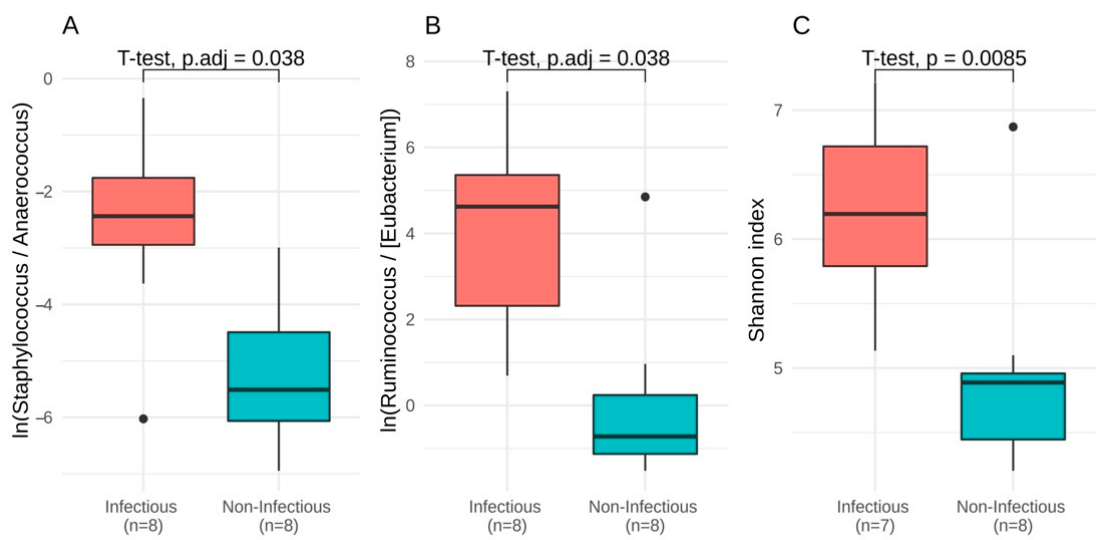
Figure 3. Difference between groups at the baseline. ( A , B ) Balances between taxa obtained by discriminative balance analysis and significantly different between groups. ( C ) Shannon index (only samples with total number of reads ≥ 3000 are